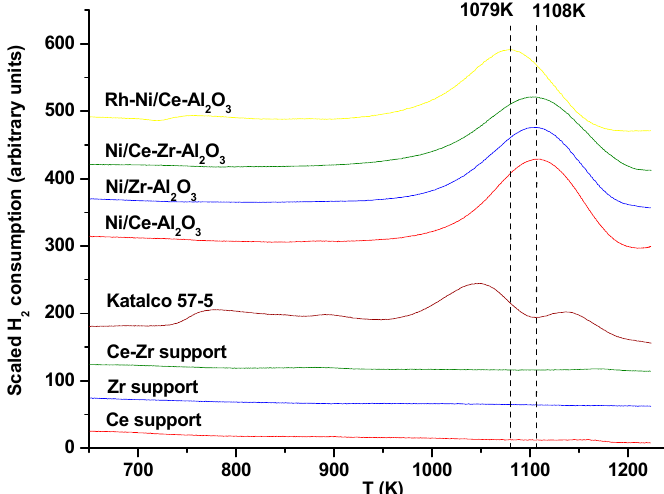
Figure A2. TPR profiles of freshly calcined catalysts and supports.